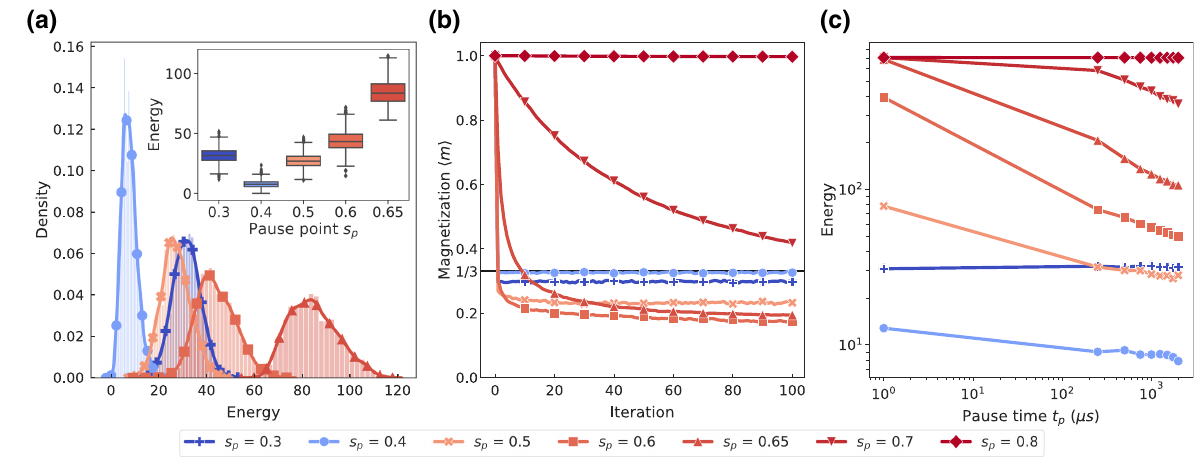
FIG. 2. Optimal QEMC annealing parameters. (a) Simulated energy distributions using QEMC chains at ( J 1 = 1, J 2 = 1, h z = 2.1 ) with t r = 1 μ s ramps and t p = 1998 μ s. The energies displayed are rescaled according to the lowest-energy configuration observed in experiment. Two values, s p = 0.7, s p = 0.8, are omitted from (a) for clarity because (cid:2) H ( s p = 0.7 ) (cid:3) ≥ 600 and (cid:2) H ( s p = 0.8 ) (cid:3) ≥ 700 lie far outside of the domain shown in (a). The inset is an alternative view of (a) that clearly shows the parabolic energy curve as a function of s p with a minimum at s p = 0.4. (b) The convergence of the magnetization from a ferromagnetic state at ( J 1 = 1, J 2 = 1, h z = 2.1 ) with t r = 1 μ s ramps and t p = 1998 μ s to the 1 magnetization plateau (shown in black). For s p < 0.5, convergence to the bulk 3 magnetization occurs in less than 5 iterations; however, these states are not energetically optimal and convergence to the correct microscopic order takes many tens of iterations. (c) The average returned energy as a function of s p and t p with t r = 1 μ s. Unless s p is sufficiently strong such that the timescale of tunneling dynamics is much shorter than the anneal time, increasing the pause time has a dramatic effect in finding low-energy